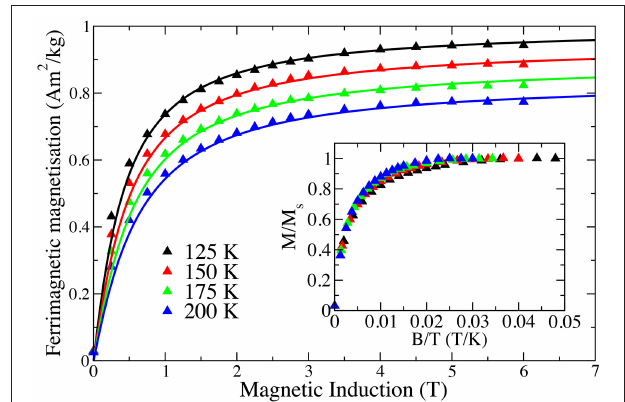
FIGURE 7 | Ferrimagnetic contribution to the magnetization at 125, 150, 175, and 200 K; the lines are fits to a Langevin law. Inset: Normalized magnetization curves scaled with temperature